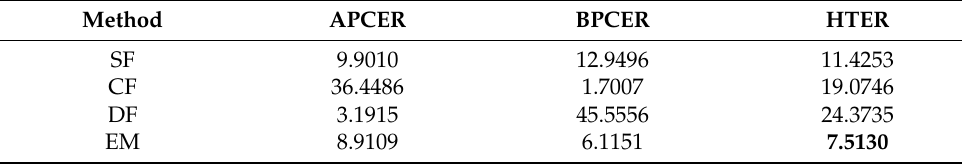
Table 2. Results (%) on our testing